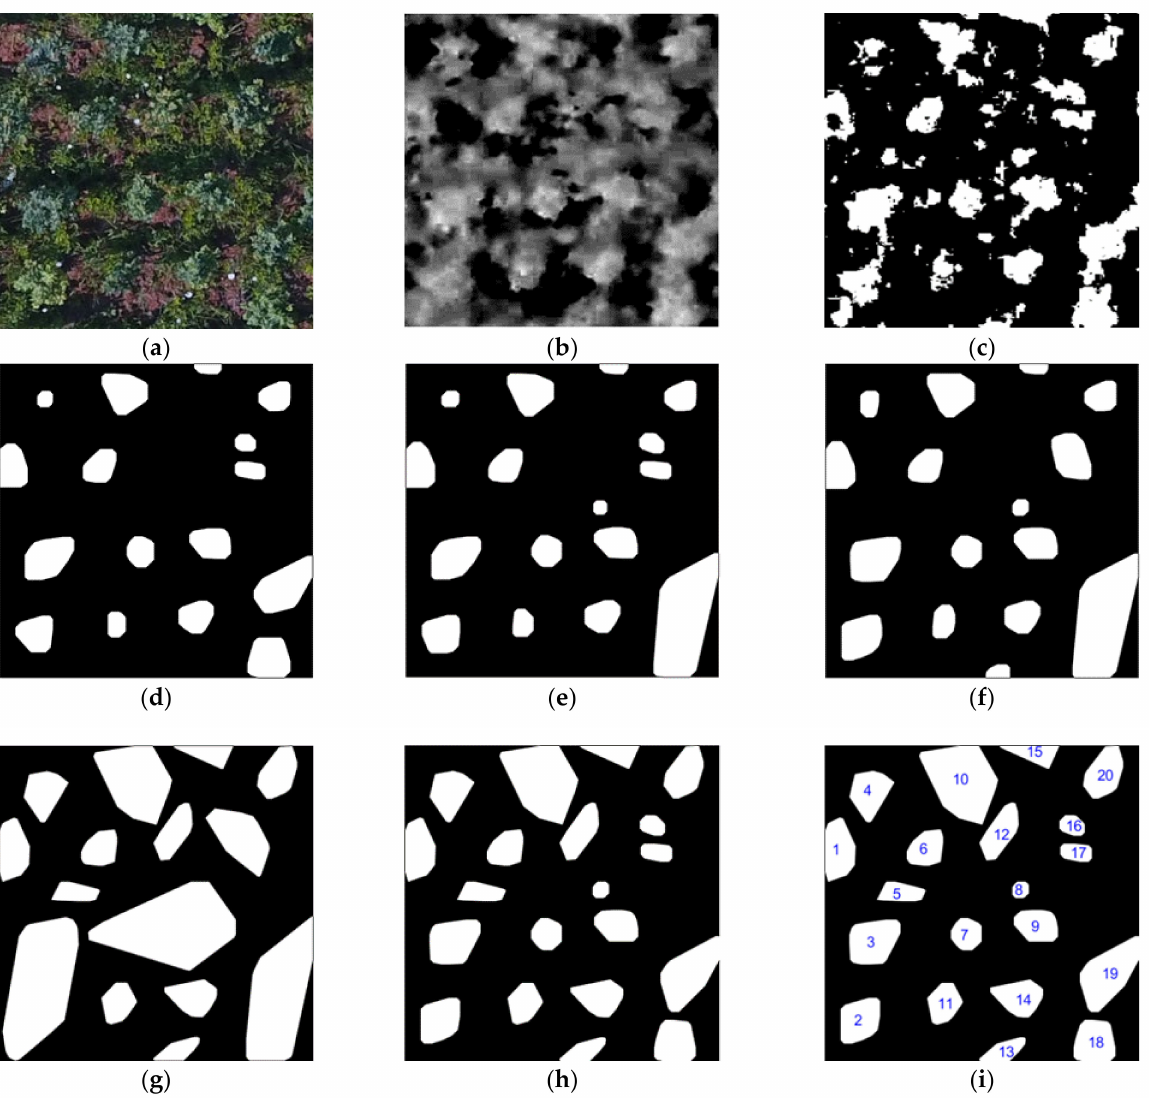
Figure 5. Tree crown extraction and fusion results of IB and high FVC images based on different radius open filters. ( a ) An example image in RGB color space. ( b ) The transformed result of ( a ) using GRDI. ( c ) The result of ( b ) using binary image transformation. ( d – g ) The extracted results of ( c ) using open filters with different radii (3, 5, 7, and 9 pixels). ( h ) The result of fusion of the four images of ( d – g ). ( i ) The result of digitally labeling the regions in Figure ( h